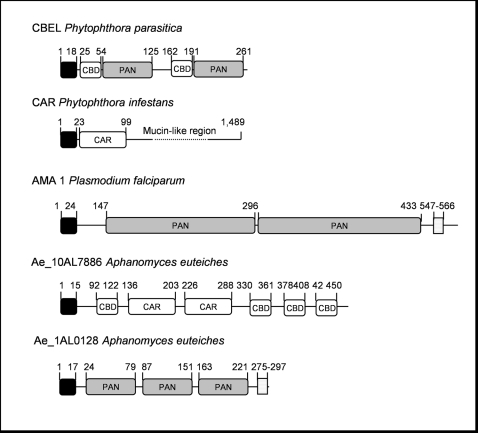
Protein domain organisation of cell surface proteins from oomycetes and apicomplexa.Two proteins from Phytophthora, CBEL and CAR which are localized at the cell surface [33], [37] are represented. CBEL contains two closely associated domains, a cellulose binding domain (CBD) and a N/apple PAN domain (PAN). CAR proteins are composed of a mucin-like region and a N-terminal region (CAR) with conserved cysteine residues. AMA1 is a P. falciparum protein with two PAN domains [39].